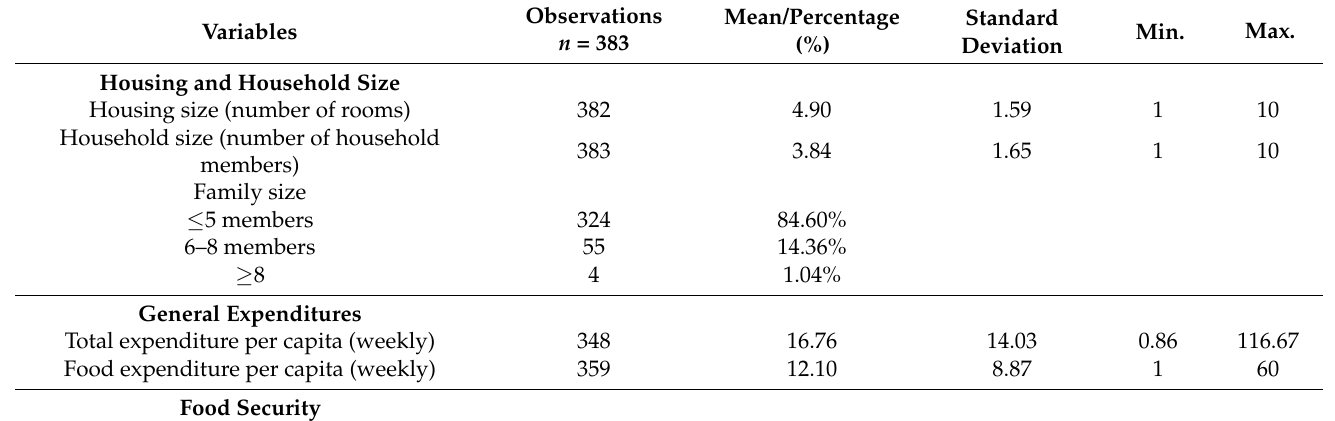
Table 1. Socioeconomic and demographic